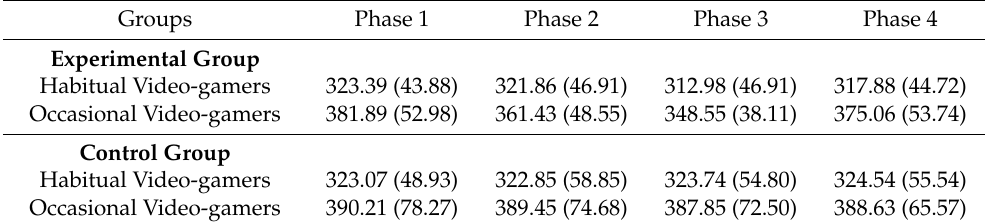
Table A1. Means (and standard deviations) of the RTs in the Visual Search Task.